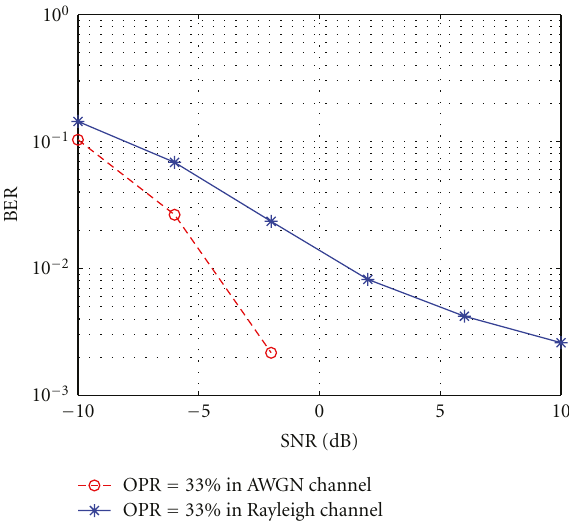
Figure 8: BER versus SNR for Rayleigh and AWGN channel.